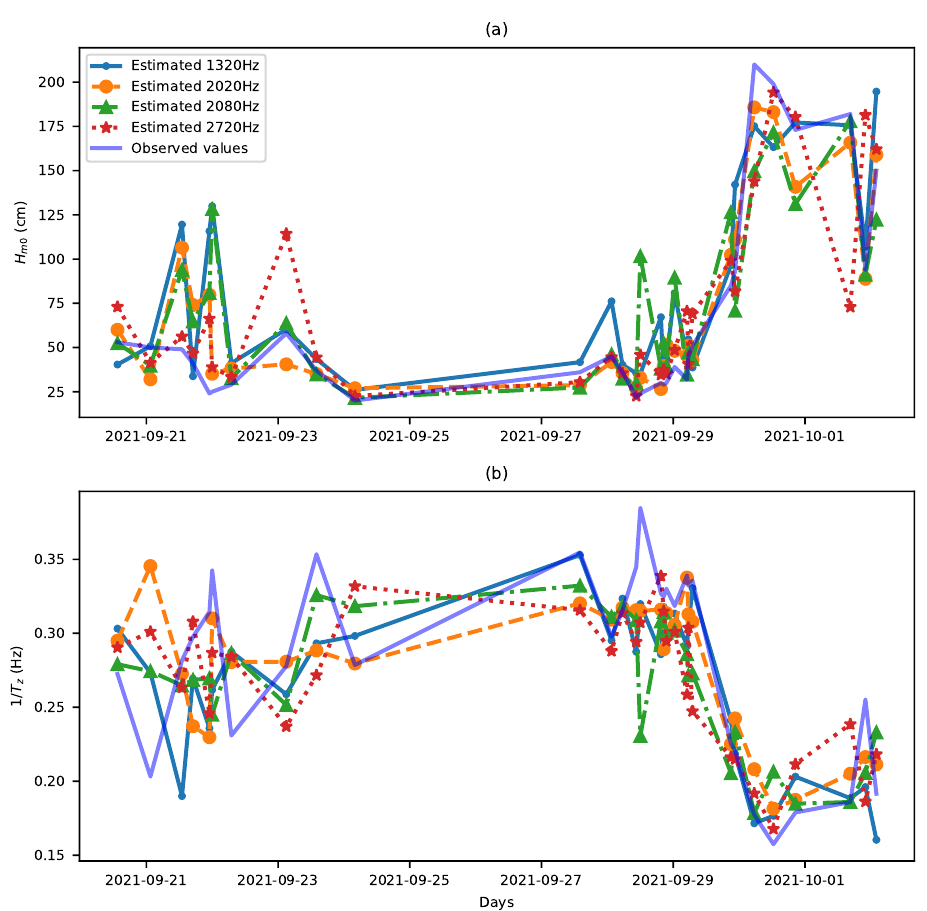
Figure 10. Comparison of 4 XGBoost regression models equipped by 20 decision trees of the max depth 10 utilizing features for different frequencies to estimate the values of ( a ) the significant wave height and ( b ) the peak wave frequency.